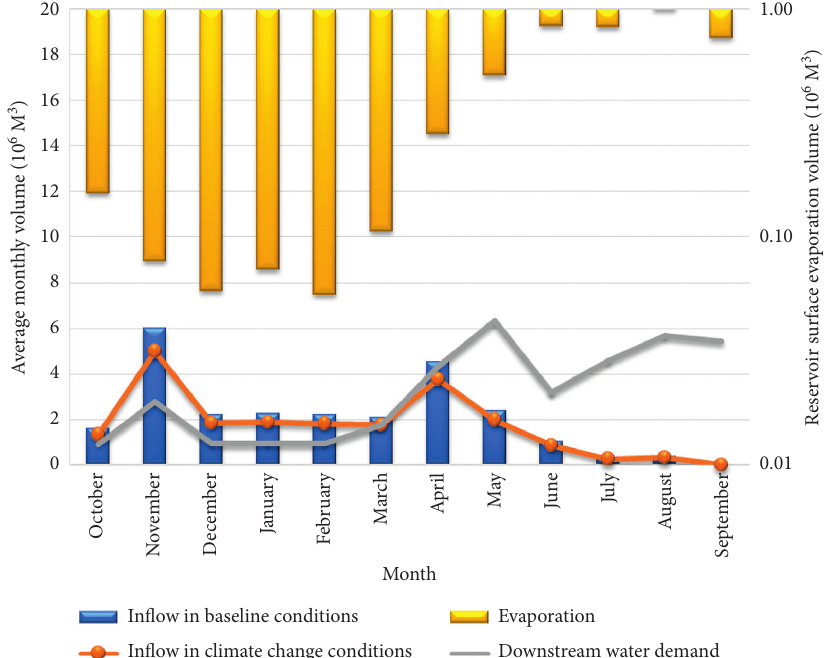
Figure 5: The average monthly release volume, as well as the monthly average evaporation volume and the monthly average demand volume, for water under baseline and climate change conditions.